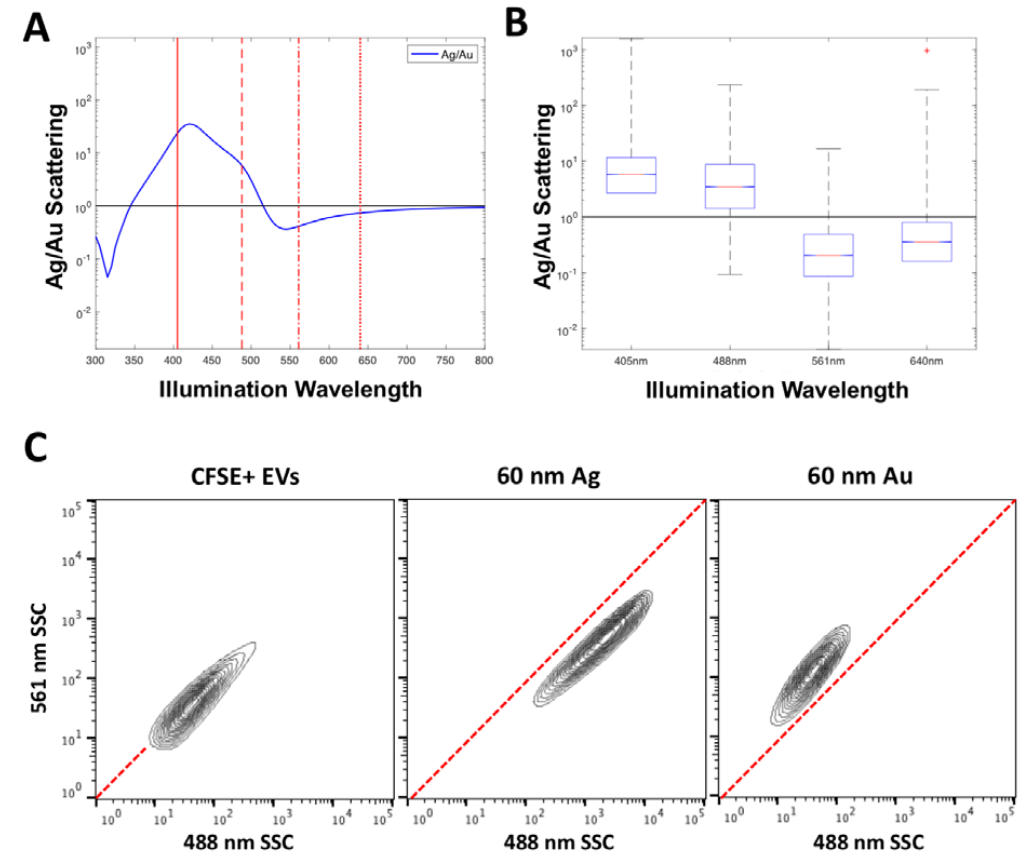
Figure 5. Simple spectral deconvulsion approaches to scattering labels. Illustrated is the predicted scattering cross-section ratio of 60 nm Ag to 60 nm Au particles ( A ), and acquired ratio of Ag to Au ( B ). Vertical red lines represent the particle scattering wavelengths (405, 488, 561, 640 nm) collected on the Astrios EQ instrument. The acquired scattering channel data for CFSE-stained EVs, 60 nm Ag, and 60 nm Au particles on 488 nm and 561 nm SSC channels ( C ). The green area indicates a higher scattering power at 561 nm, while the red area indicates a higher scattering power at 488 nm. The red dotted line indicates an equal scattering power at 561 nm and 488 nm.